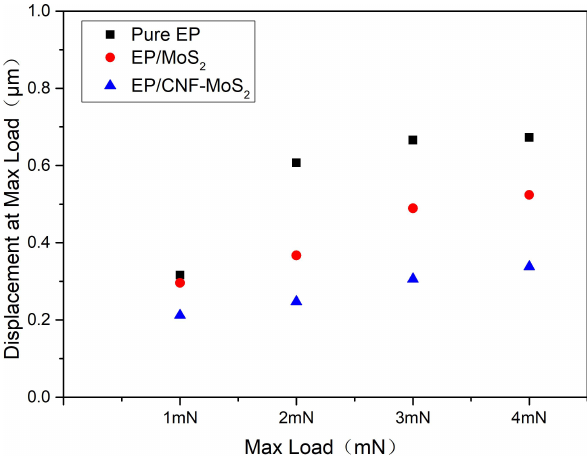
Figure 12: Total creep displacement of different materials at differ- ent max load in the holding